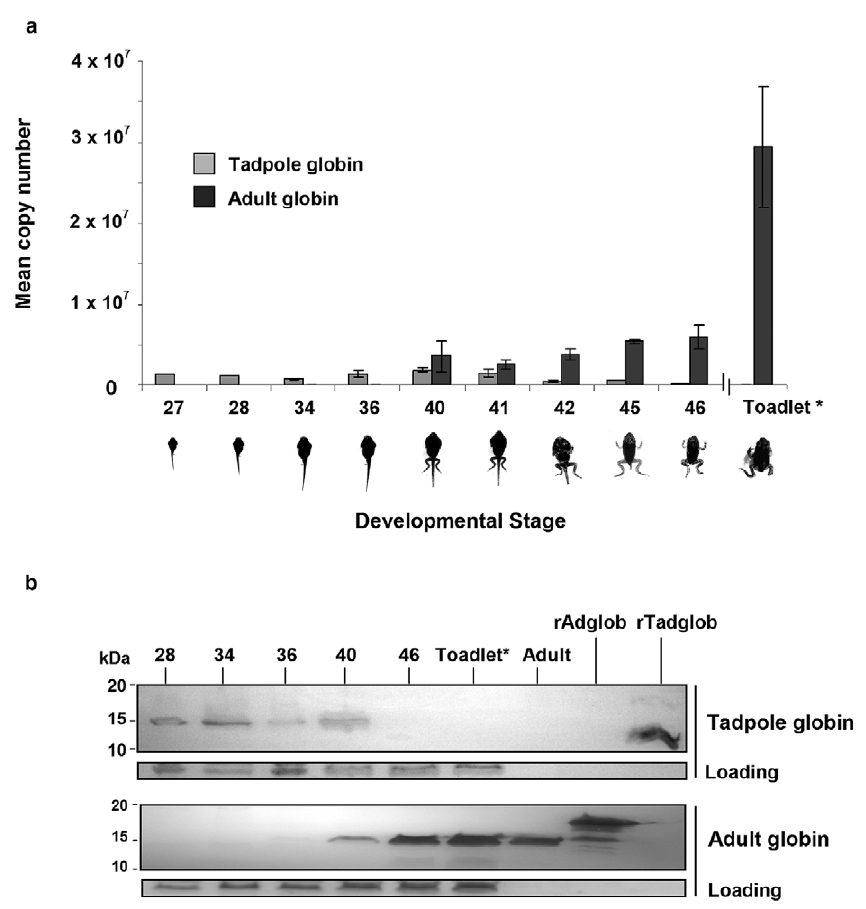
Figure 1. Tadpole to adult globin switch detected in normal cane toad development. a: mRNA data expressed as number of copies of adult or tadpole globin mRNA detected by real time PCR across various tadpole and metamorphic stages. Mean copy numbers were normalised using a toad actin housekeeping gene. Animals were staged according to Limbaugh and Volpe, 1957. Toadlet (*) development was approximately one month post-metamorphosis. b: Detection of globin proteins as determined by western blot analysis using specific antibodies to tadpole and adult globins. Coomassie staining indicates the loading level for each lane. Recombinant proteins for adult and tadpole globin (rAdglob and rTadglob, respectively), as well as native adult globin (Adult) were included as positive controls.